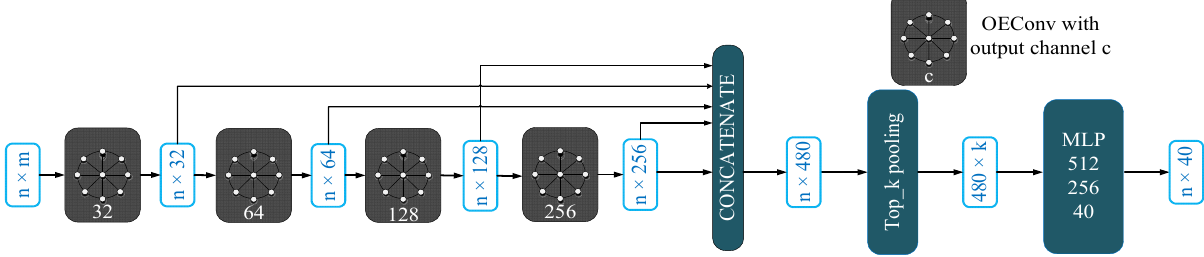
Figure 6. The architecture of a 4-layer OECNN in ModelNet40 [19] classification.